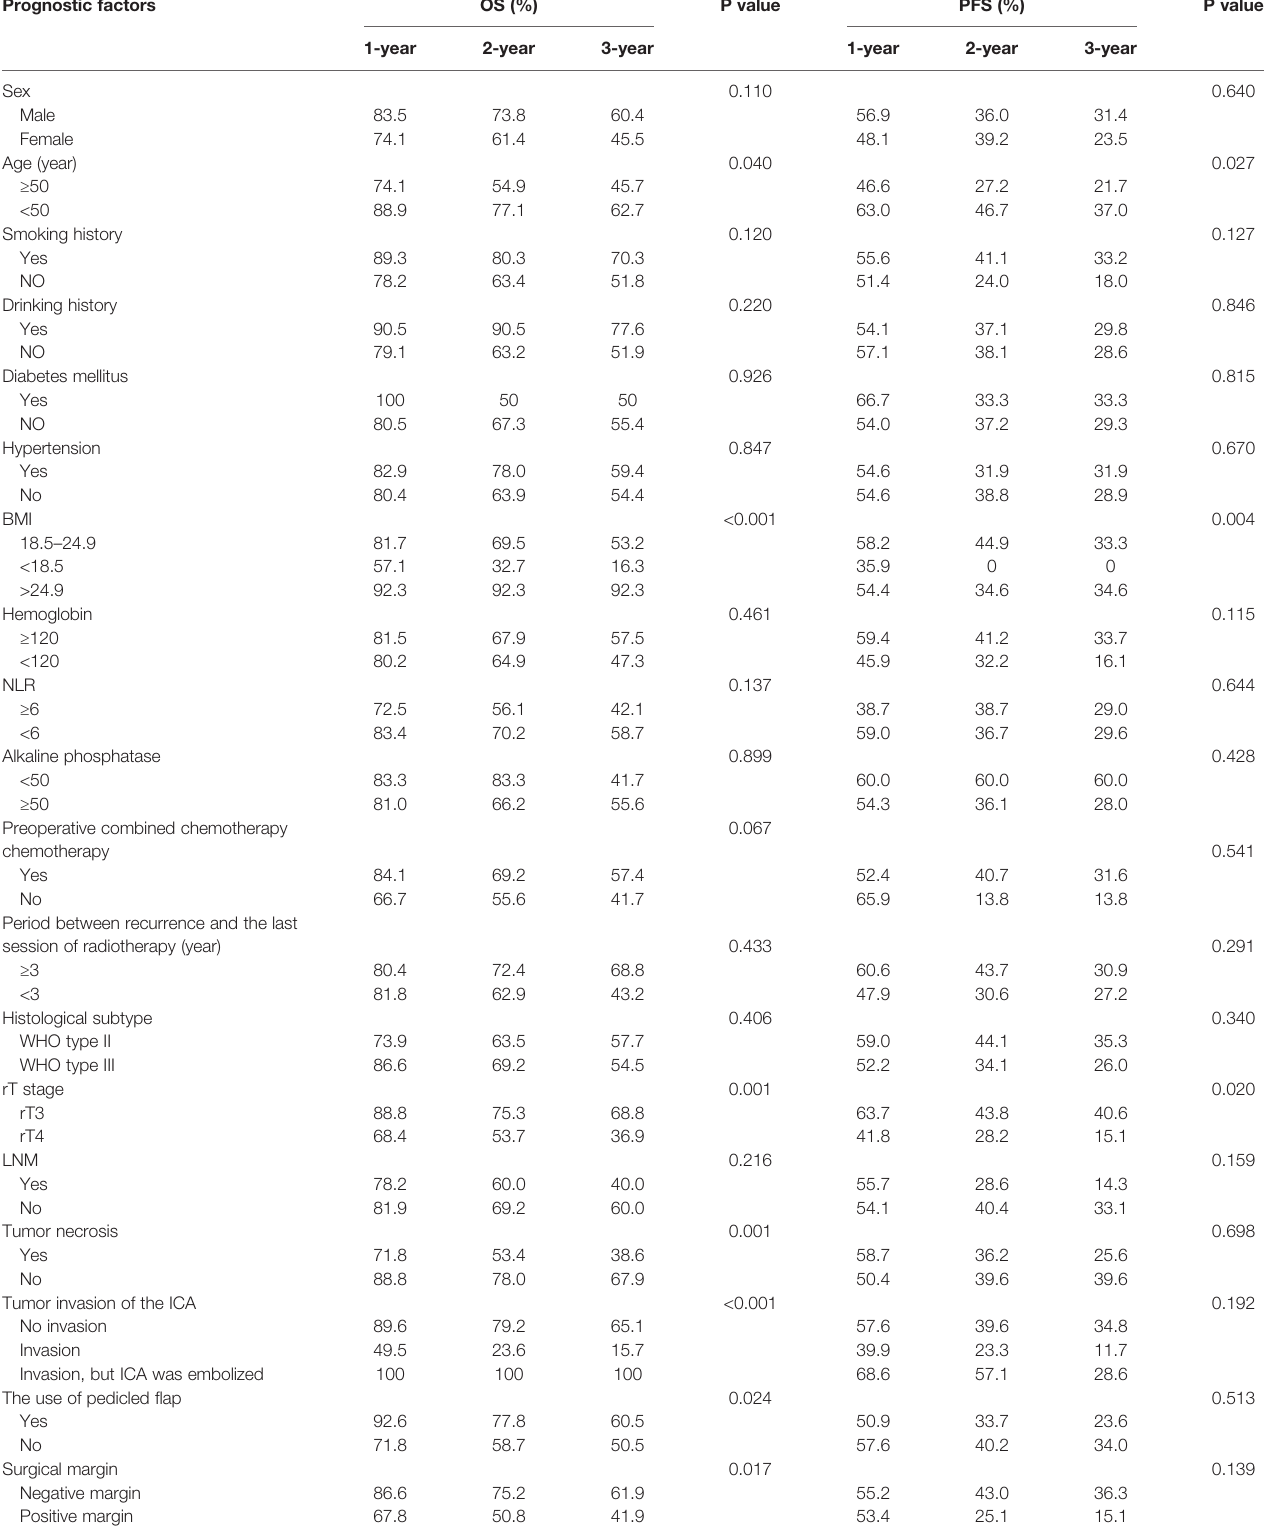
TABLE 3 | Log-rank test of prognostic factors for rNPC. Prognostic